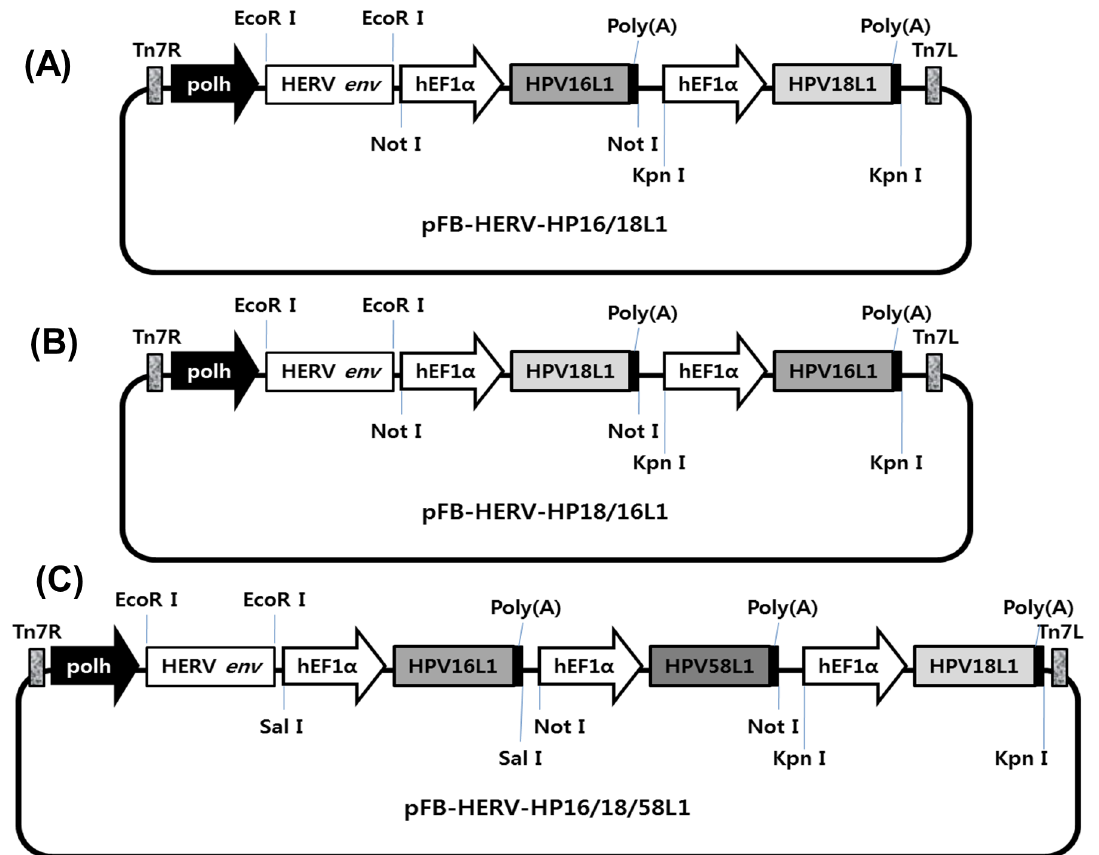
Figure 1. Scheme of transfer plasmids for construction of recombinant baculoviruses. The structure of the transfer plasmid was derived from pFastBac1. In all plasmids, Polh (polyhedron promoter of baculovirus) was used as a promoter of HERV env gene. As a polycistronic promoter, hEF1 a was used for HPV16, 18, and 58L1 genes. For each plasmid, poly(A) (polyadenylation signal) was inserted at the end of each target gene. (A) pFB-HERV-HP16/18L1 was constructed by putting HPV 16L1 gene ahead of HPV 18L1. (B) pFB-HERV-HP18/16L1 was constructed by putting HPV 18L1 gene ahead of HPV 16L1. (C) pFB-HERV-HP16/18/58L1 was constructed by inserting HPV 58L1 gene between HPV 16L1 to HPV 18 L1 gene.